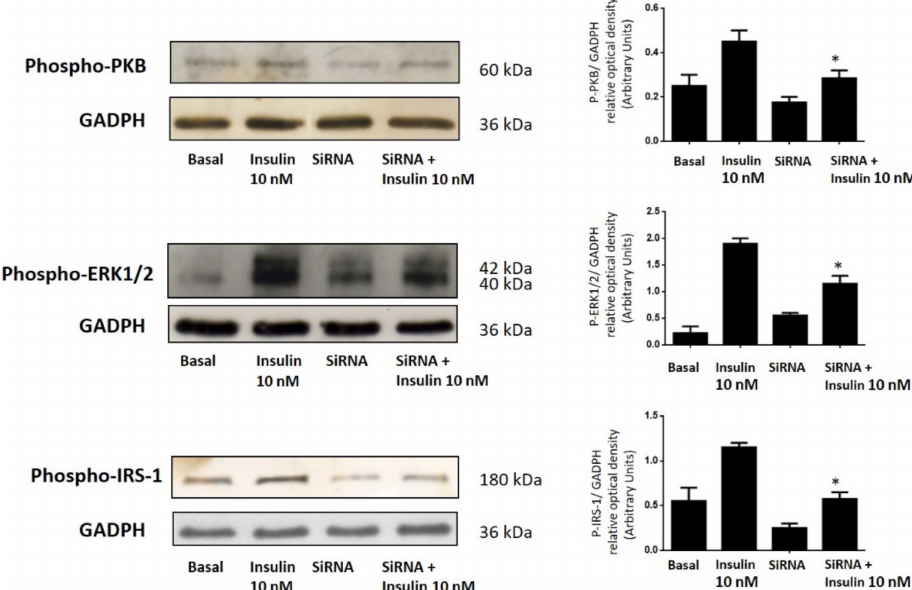
Figure 3. Sam68 siRNA prevents the insulin-dependent activation of PI3K and MAPK pathways in human GCs from healthy donors. GCs were transfected with Sam68 siRNA or NC1-scrambled nega- tive control siRNA (basal) duplexes, as described in Section 2, and incubated in absence or presence of 10 nM insulin for 10 min. GC lysates were separated by SDS-PAGE, and Western blot analysis was performed by using anti-P-PKB, anti-P-ERK1/2, and anti-P-IRS-1 antibodies to study insulin activation of the PI3K and MAPK signaling pathway. Sample protein loading was controlled by using anti-GAPDH antibodies. We show the corresponding densitometric analysis of three independent experiments as means ± SD; statistical analyses were performed by ANOVA. Asterisks indicate significant differences from the untreated controls according to Bonferroni’s multiple comparison post-hoc